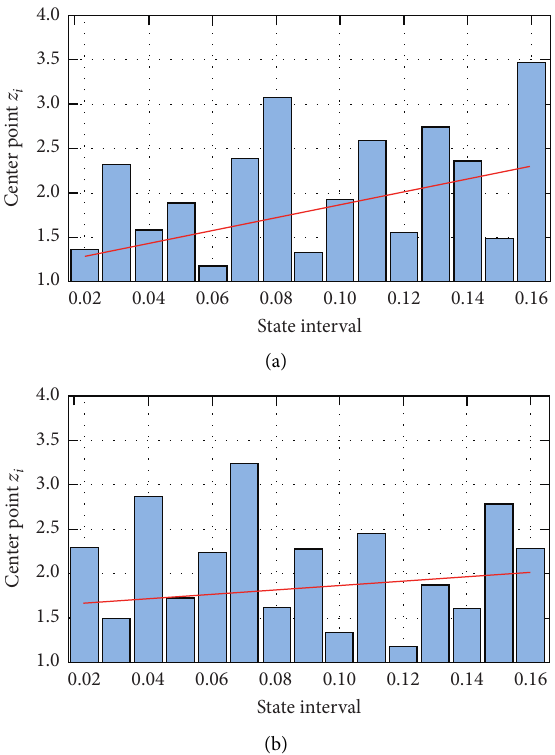
Figure 2: Distribution of center point in different state intervals for similarity measure (a) and item clustering